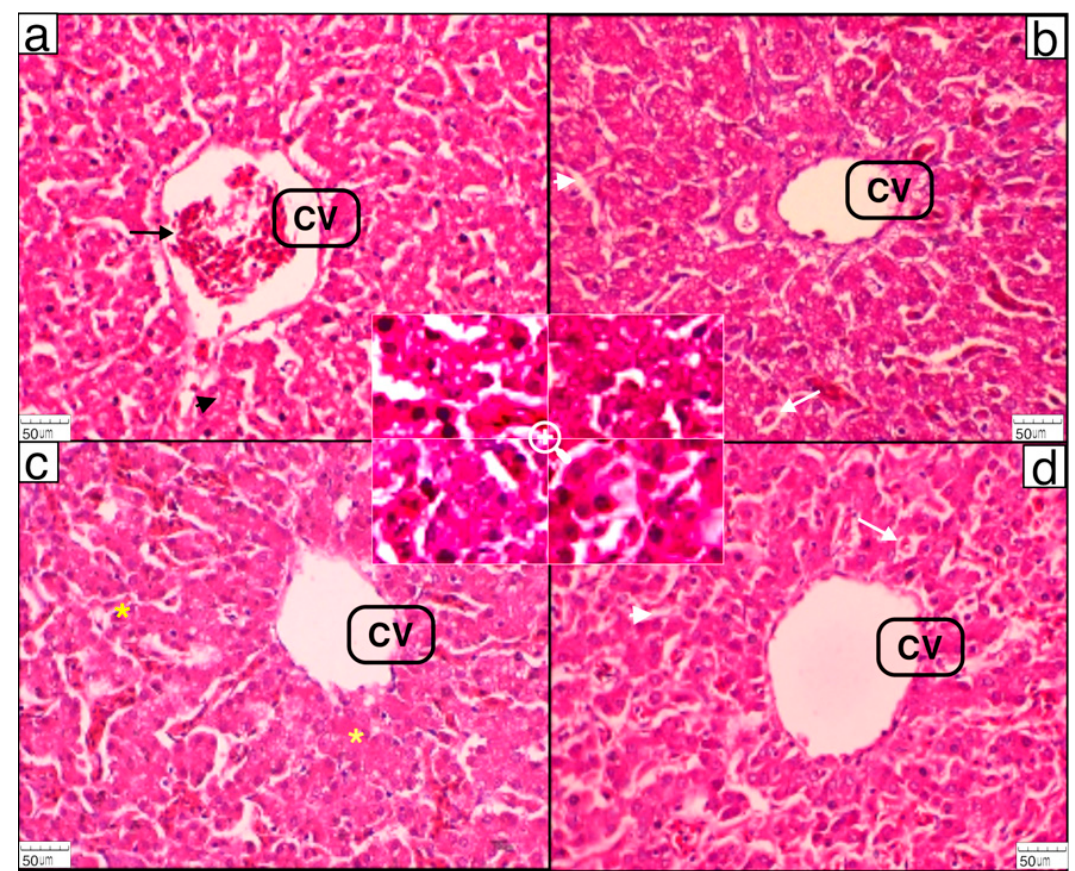
Figure 1. Photomicrograph image. ( a ) Liver lobule section of the control group, showing partial congestion (black arrow) in the central vein (CV) and vacuolar degeneration of the hepatocytes (black arrowhead). ( b–d ) Liver lobule sections of the Po2, Po4, and Po8 groups, showing central veins with intact endothelia, RBCs within sinusoids (white arrow), and radiating sinusoidal spaces (white arrowhead); there is no evidence of the infiltration of inflammatory cells in the liver parenchyma. ( c ) Hepatocytes showing normal architecture (asterisk) . The magnified area in the center of the image shows histomorphological features of hepatocytes, where the hepatocytes in the Po8 group ( d ) have the clearest and healthiest architecture compared to the other groups (H&E:Haematoxylin and Eosin; 400X).